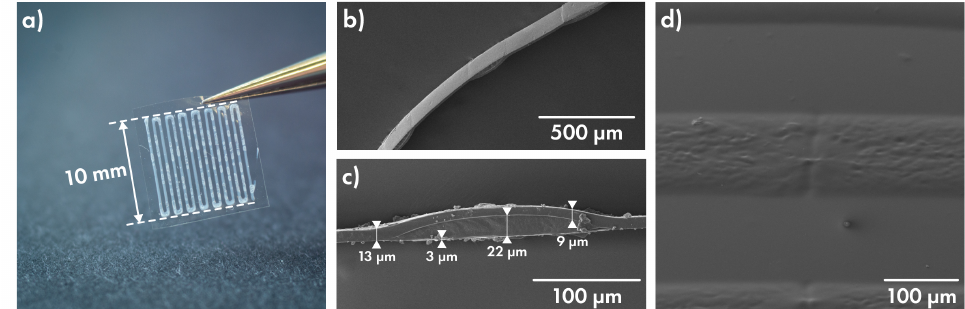
Figure 6. ( a ) Cefazolin-containing film sample, SEM images of its edge ( b , c ) and of cover film-coated drug surface ( d